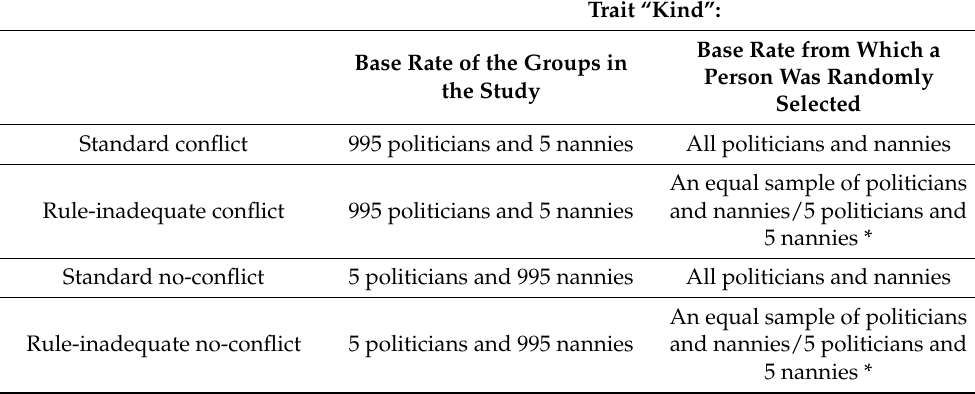
Table 3. Information displayed in conflict/no-conflict and standard/rule-inadequate problems in the base-rate neglect tasks of the present studies. For a Person Randomly Selected from the Sample with the Trait “Kind”: Base Rate from Which a Base Rate of the Groups in Person Was Randomly the Study Selected Standard conflict 995 politicians and 5 nannies All politicians and nannies An equal sample of politicians Rule-inadequate conflict 995 politicians and 5 nannies and nannies/5 politicians and 5 nannies * 5 politicians and 995 nannies All politicians and